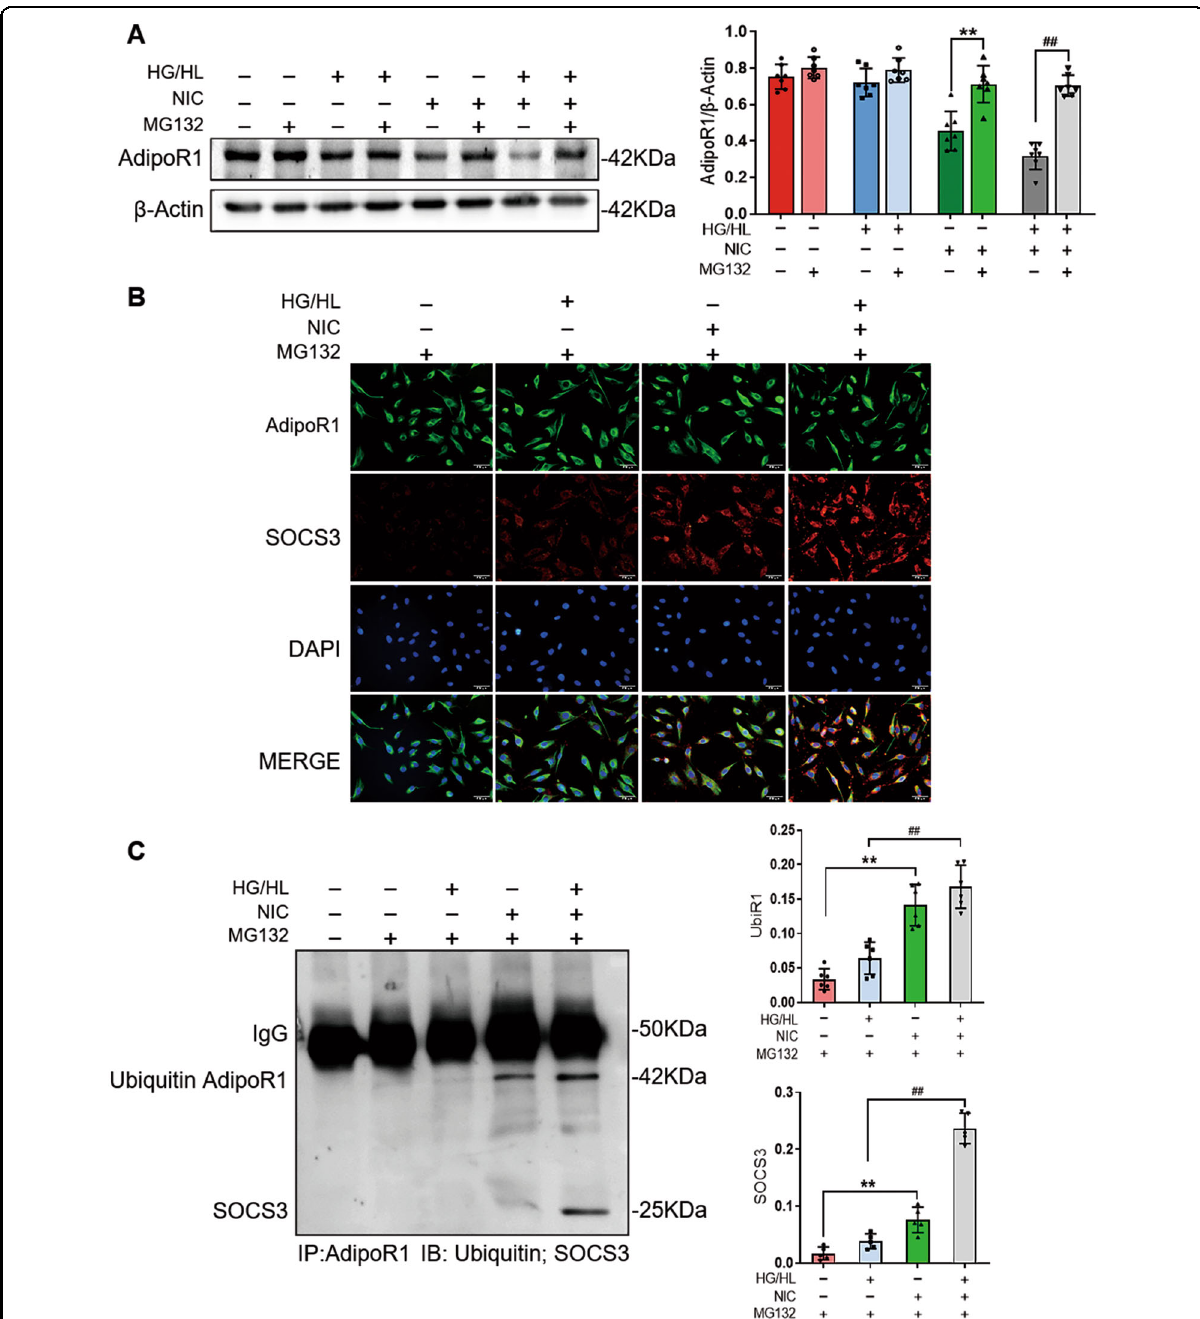
Fig. 4 Nicotine increased the ubiquitin-mediated AdipoR1 degradation via SOCS3. A MG132 partially reversed NIC + HG/HL-induced AdipoR1 reduction. n = 6 dishes/group. ** P < 0.01 vs. NIC group; ## P < 0.05 vs. NIC + HG/HL group. Data were analyzed by two-way ANOVA. B Immuno fl uorescence assay showed that NIC or HG/HL-promoted AdipoR1 degradation was blocked by MG132 in HUVECs (scale bar = 50 μm). C The interaction between SOCS3 and ubiquitinated AdipoR1 was evidenced by co-immunoprecipitation assay. n = 6 dishes/group. ** P < 0.01 vs. control + MG132 group; ## P < 0.05 vs. HG/HL + MG132 group. Data were analyzed by one-way ANOVA. NIC, nicotine; HG/HL, high glucose/high lipid; UbiR1, ubiquitinated